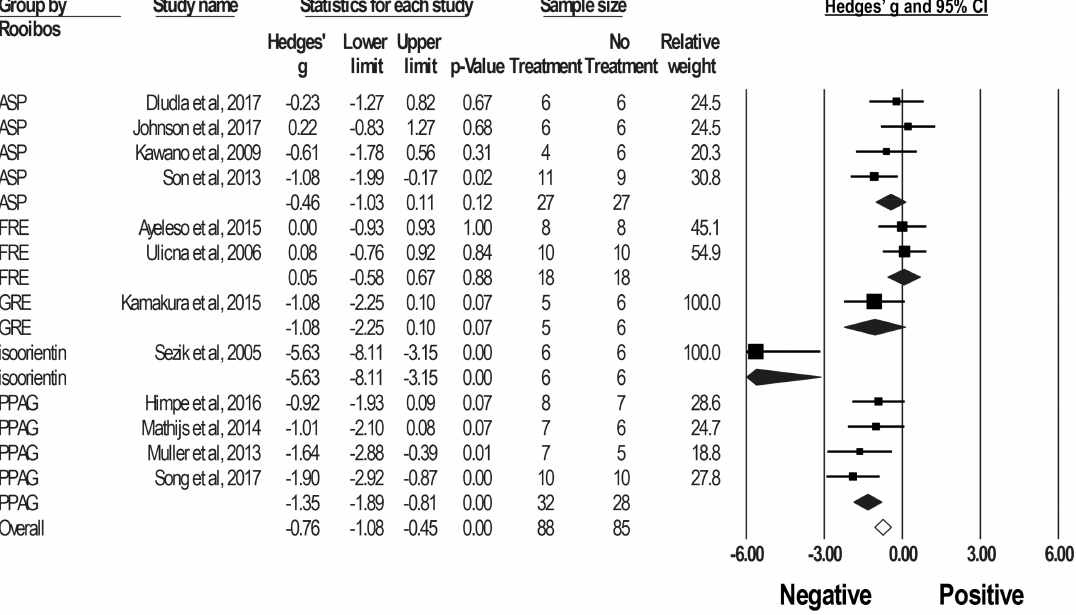
Figure 3. Subgroup analysis for Hedges’ g of blood glucose levels in DM rodents treated with various types of rooibos extracts and major phenolic compounds or vehicles. Summary estimates were analyzed using a random-effects model. CI, confidence